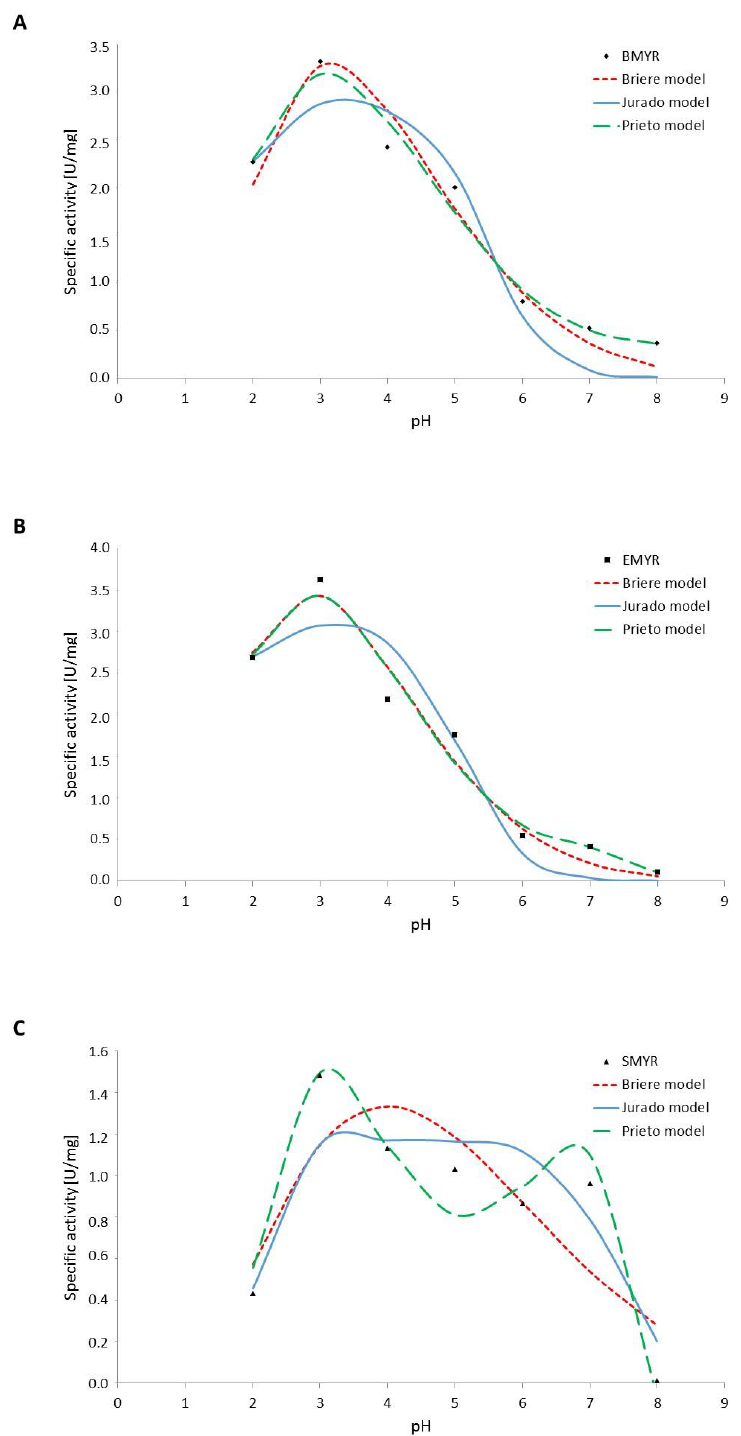
Figure 4. Adjustment of the pH-dependent models of Prieto, Briere, and Jurado models to kinetic data of ( A ) BMYR, ( B ) EMYR, and ( C ) SMYR.